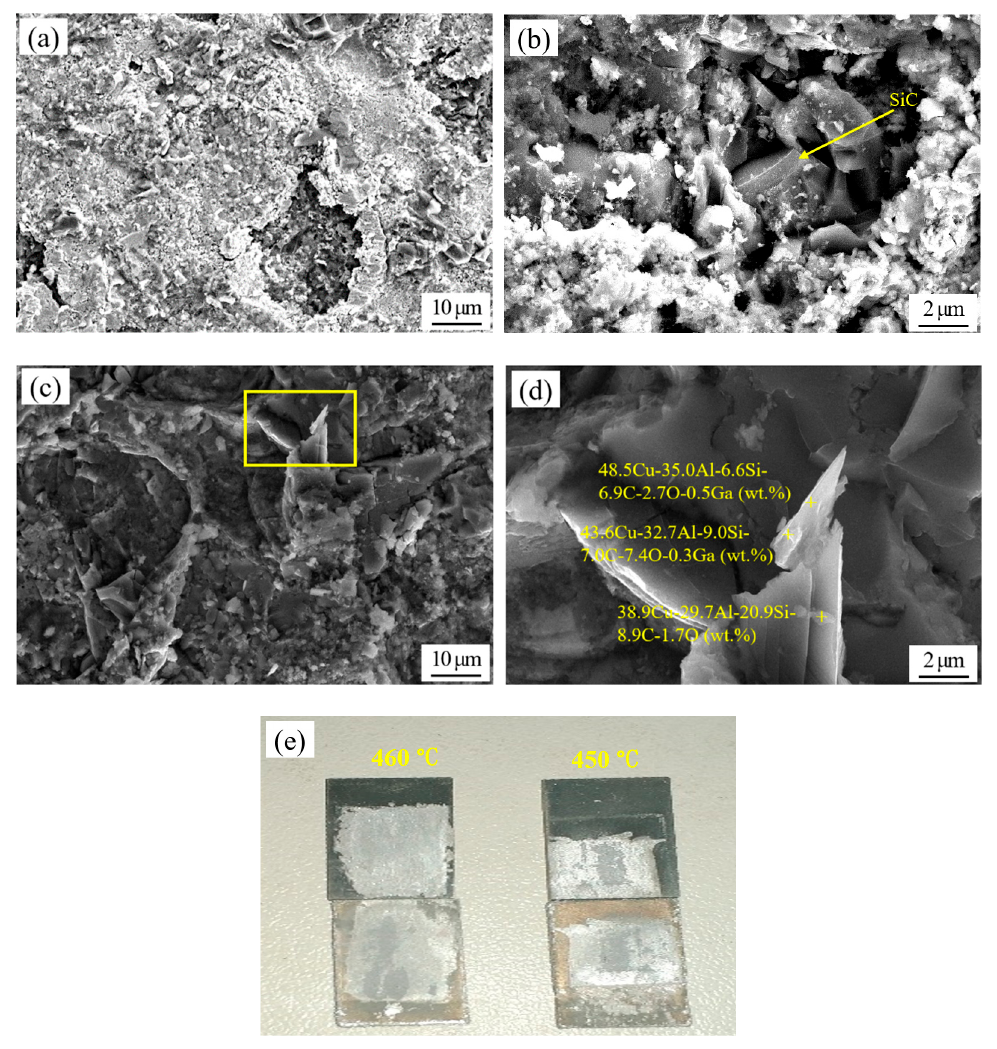
Figure 9. Scanning fracture appearance and EDS analyses of the joints made using liquid gallium with nano-copper particles at ( a , b ) 450 °C and ( c , d ) 460 °C. ( e ) Cross-section of joints after shear test.